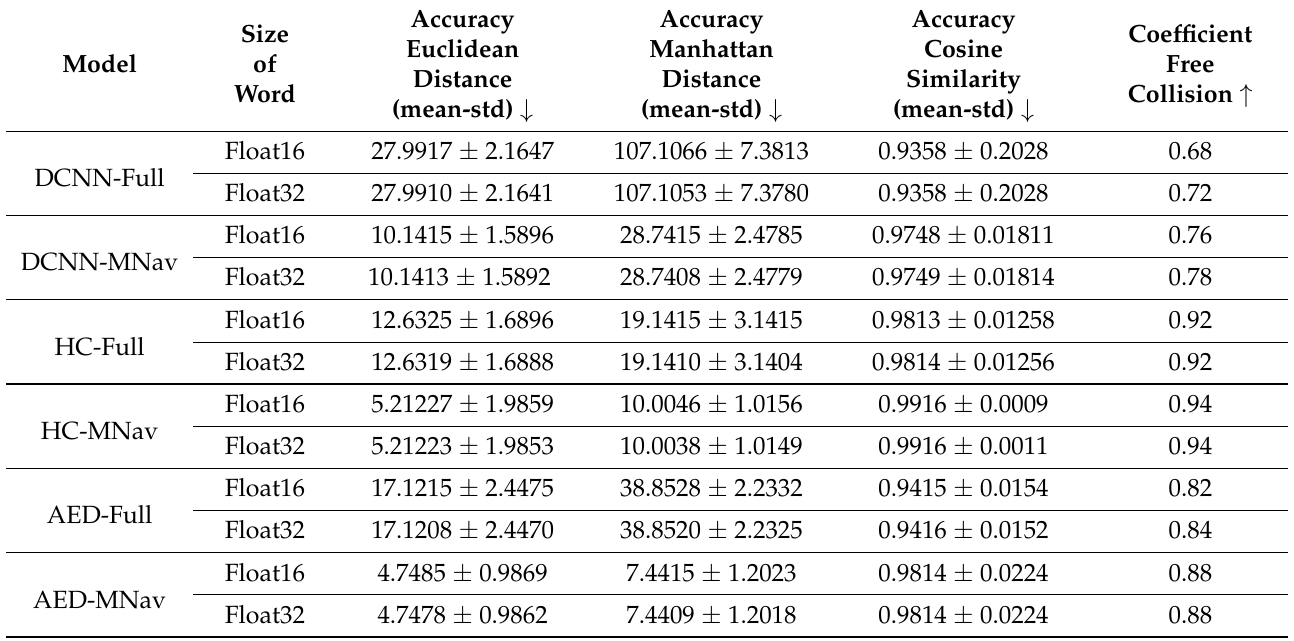
Table 5. Performance of the transfer-learning approach and its standard deviation in 50 samples. ↓ , lower is better; ↑ , higher is better.